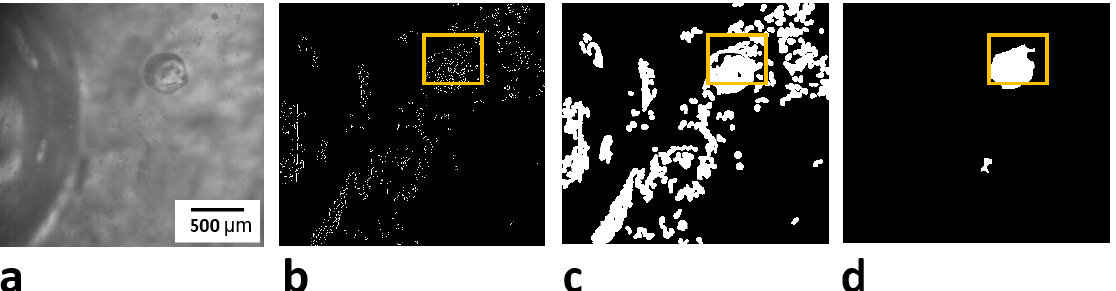
Figure 11. ( a ) HT-CSLM microscopy image of the silica inclusion suspended in the slag at a temper- ature of 1558.8 °C and time 473.40 s. ( b ) Image of the inclusion after running the Canny edge detec- tion method on Figure 3a. ( c ) Dilated image of the inclusion that was segmented by edge detection. ( d ) Morphologically constructed inclusion after a sequence of erosion and hole-filling operation on MATLAB.